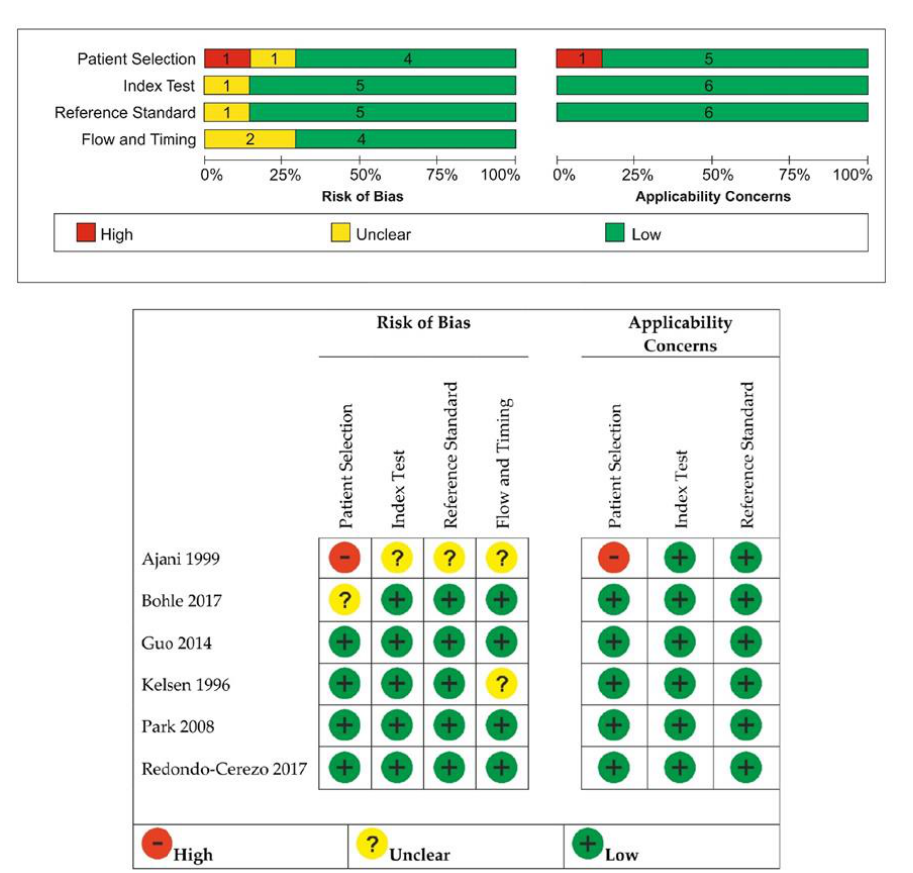
Figure 2. The review authors’ judgment about each domain of bias and applicability concerns across the included studies.